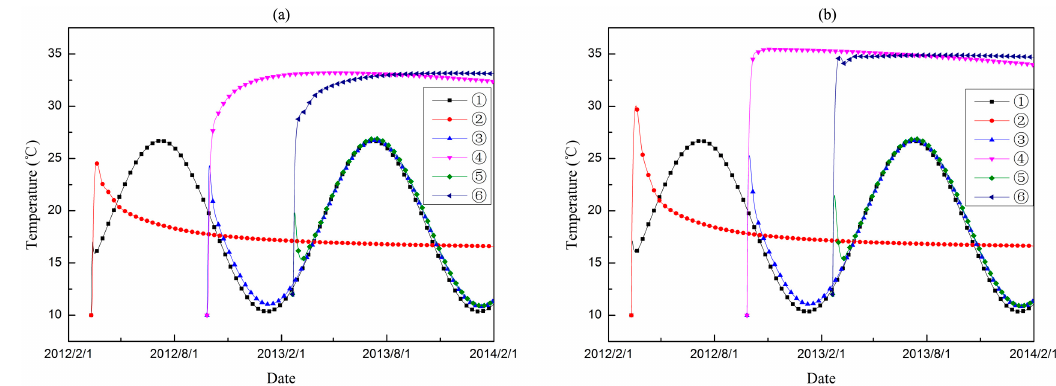
Figure 16. The temperature histories of different typical points. ( a ) thermo-chemical-mechanical coupled model; ( b ) conventional model.